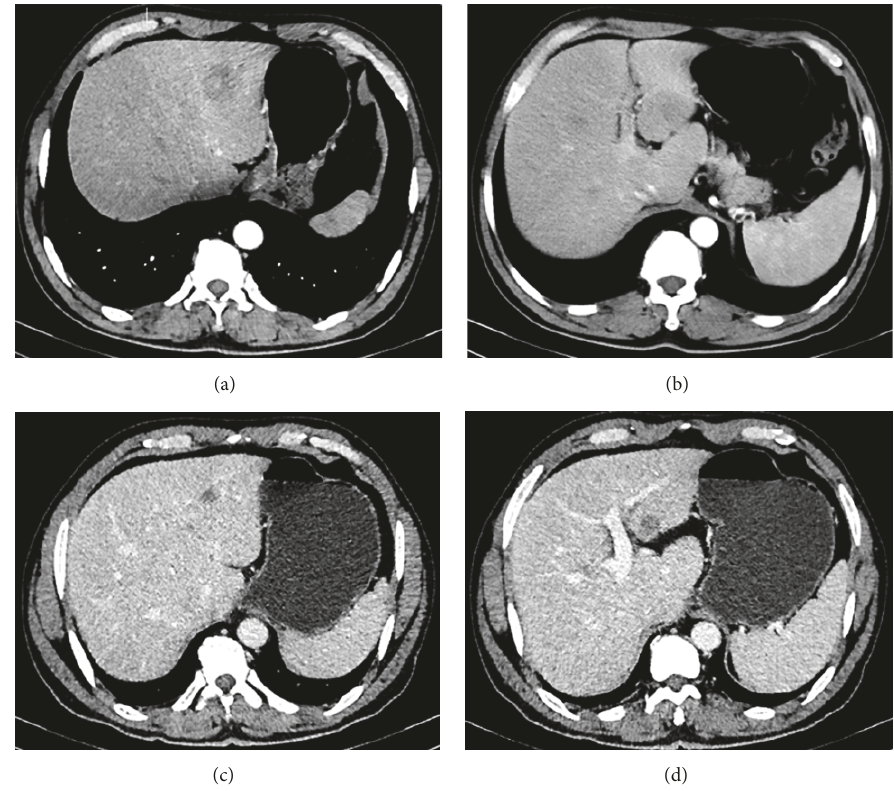
Figure 4: Initial abdominal computed tomography scan (a, b) and follow-up scan after three cycles of EOX chemotherapy (c, d) . (a) Scan shows that the metastatic lesion in liver segment 4; (b) hypodense metastatic lesions in the left lobe of liver; (c) scan shows that the metastatic lesion in liver segment 4 has decreased in size from 2.8 cm to less than 0.9 cm; (d) scan shows that the metastatic lesion in the left lobe of liver has decreased in size from 4.3cm to less than 1.5